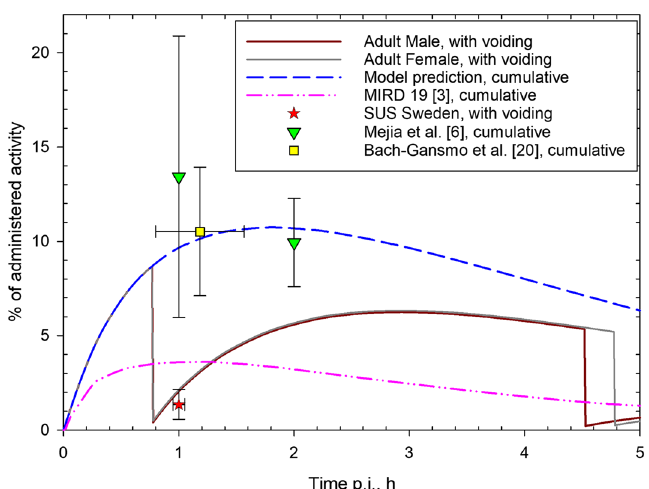
Fig. 3 TACs in source region urinary bladder contents. The blue dashed line gives the TAC under the assumption of no voiding, i.e. it corresponds to the cumulative excretion of 2‑[ 18 F]FDG in urine. The red and grey solid lines display the TACs as predicted by the dynamic bladder model with the first voiding at 45 min p.i. for male and female adults, respectively. The purple dashed‑dotted line gives the prediction of the MIRD model [3] (cumulative excretion). The red star corresponds to the average value of the bladder activities assessed in this study (SUS: Skåne University Hospital); the green triangles and the yellow square—to the cumulative excretion reported by Mejia et al. [6] and Bach‑Gansmo et al. [20], respectively. All values are expressed as % of administered activity, and not corrected for physical decay